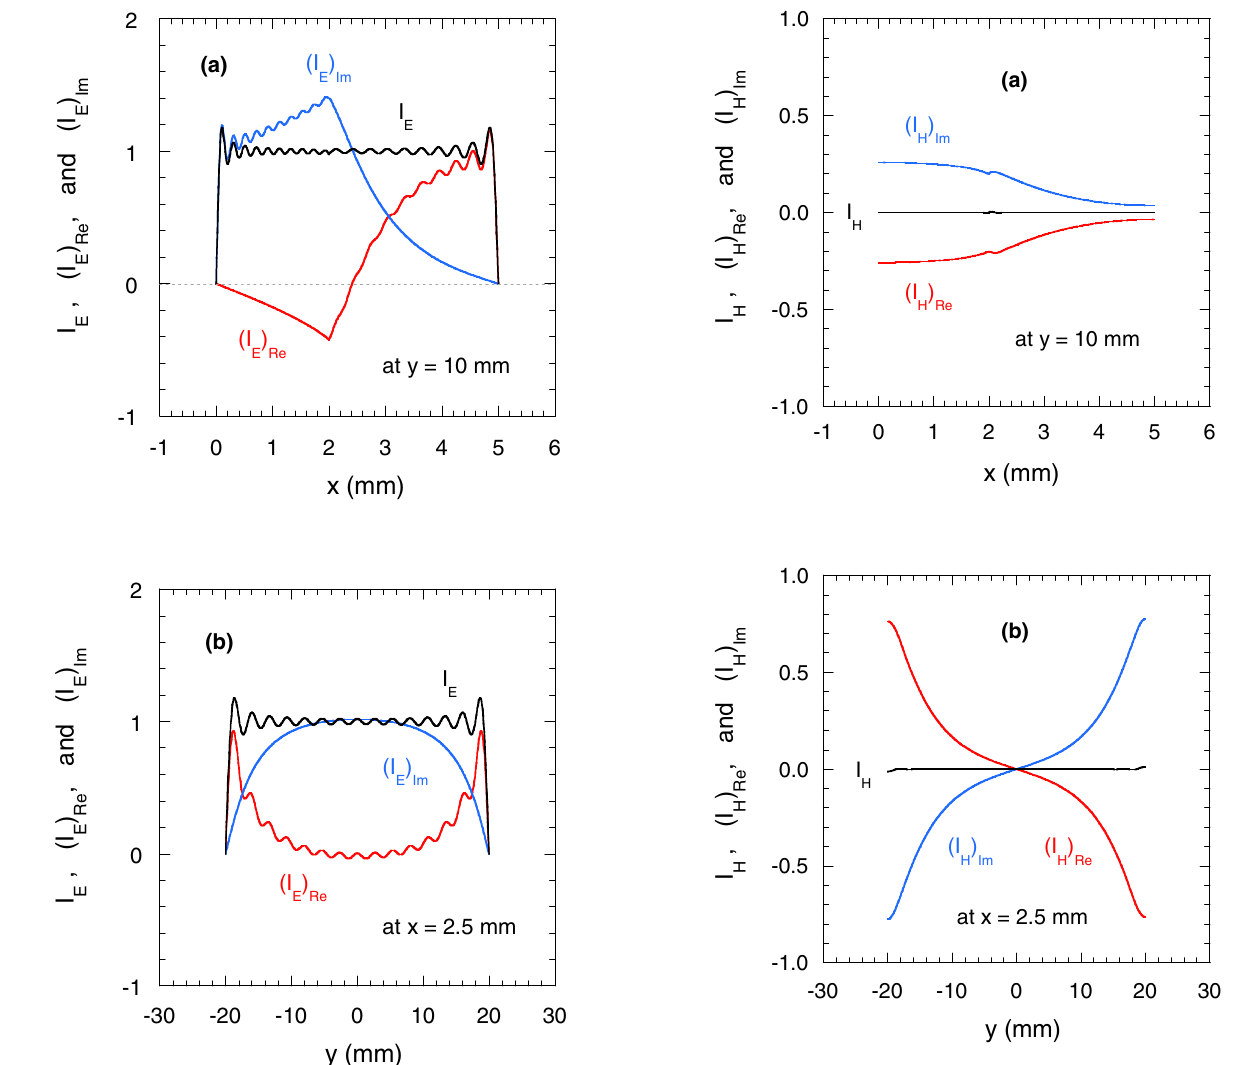
FIG. 5. (Color) Profiles of quantities I (cid:2) (cid:2) FIG. 4. (Color) Profiles of quantities I , (cid:1) I , and (cid:1) I for a the two-zone DLW structure with parameters given in Fig. 4. (a) E E E Re Im rectangular two-zone DLW structure with a width of 5 mm and a Profiles at y (cid:4) 10 mm ; (b) profiles at x (cid:4) 2 : 5 mm . It is seen that height of 40 mm. The first zone ( 0 < x < 2 mm ) is a vacuum the contributions from real and imaginary modes cancel each channel and the second zone ( 2 mm < x < 5 mm ) is a dielectric well converges to other so that I H (cid:4) 5 : 7 and (cid:1) (cid:4) 1 . (a) Profiles at y (cid:4) 10 mm ; (b) slab with " r 2 r 2 ripples around unity and profiles at x (cid:4) 2 : 5 mm . It is seen that I E goes to zero rapidly on the waveguide walls x (cid:4) 0 and 5 mm in (a), and y (cid:4) (cid:13) 20 mm in (b) required by boundary conditions. (cid:1) r (cid:2) converges reasonably to unity from Figs. 4 and 5 that I E (cid:1) r (cid:2) converges to zero. Clearly, the contribution while I H from imaginary eigenmodes is essential in such a case; the set of real eigenmodes alone is not complete. Figure 6 shows two 3D plots for a direct demonstration of identities (cid:1) x; y (cid:2) (cid:4) left-hand side of Eqs. (17) and (18), where I EE (cid:1) x; y (cid:2) (cid:4) left-hand side of Eq. (18) multi- Eq. (17) and I EH p (cid:1)(cid:1)(cid:1)(cid:1)(cid:1)(cid:1)(cid:1)(cid:1)(cid:1)(cid:1)(cid:1)(cid:1)(cid:1)(cid:1) (cid:4) 2 : 5 mm and y (cid:4) 0 . In =" (cid:1) , both with x plied by " 0 0 0 0 the computations, the mode index ranges are reduced for clarity from ( 1 (cid:12) m (cid:12) 20 , 1 (cid:12) n (cid:12) 30 ) to ( 1 (cid:12) m; n (cid:12)